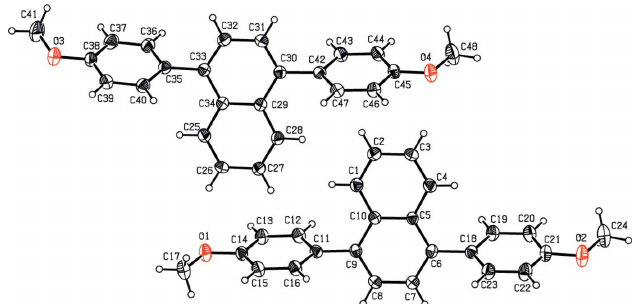
Figure 1 The molecular structures of the title compound showing atom-numbering scheme and displacement ellipsoids at the 30% probability level. The H atoms are shown as spheres of arbitrary radius.